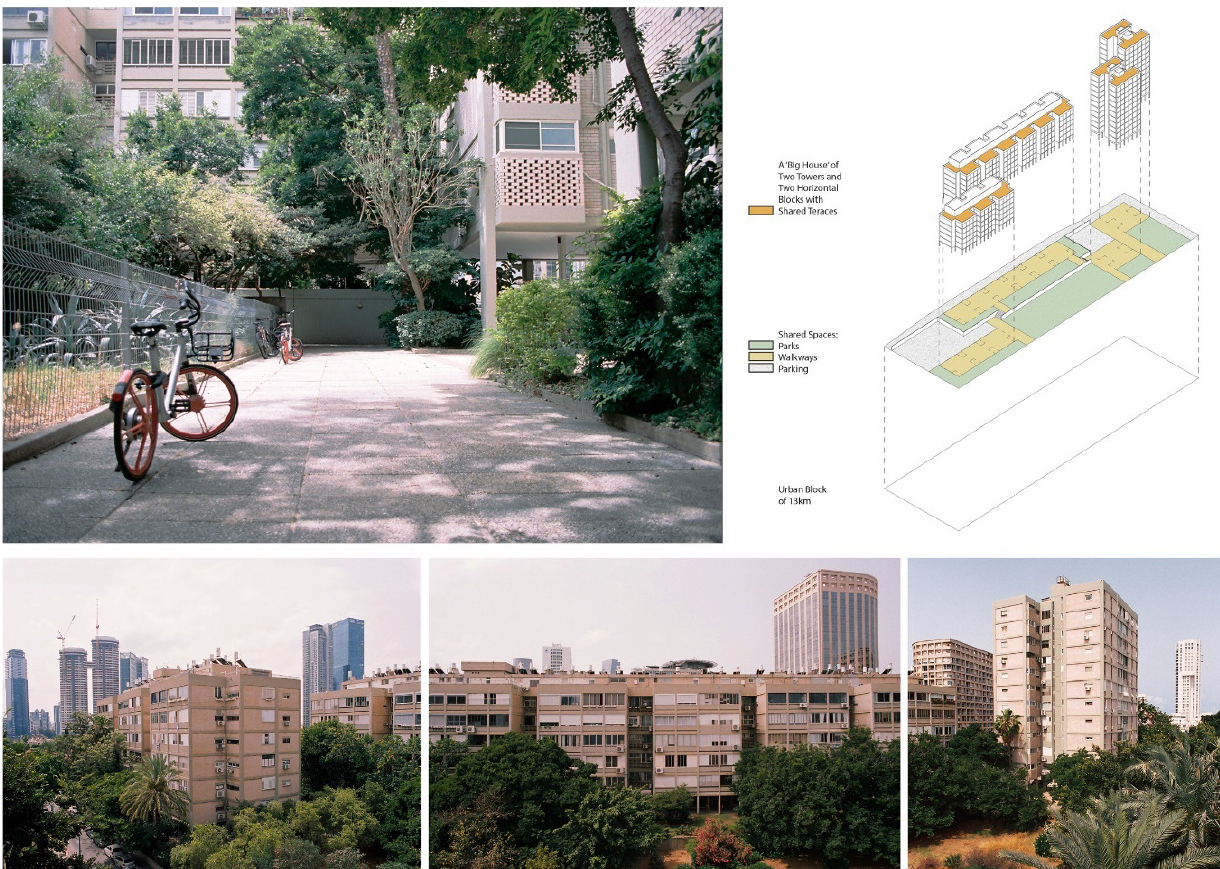
Figure 2. Top: Be’eri estate axonometric view (right) and Be’eri estate’s internal pathways (left). Bottom: The estate as an urban unit. Source: Photos courtesy of Guy Margolin,